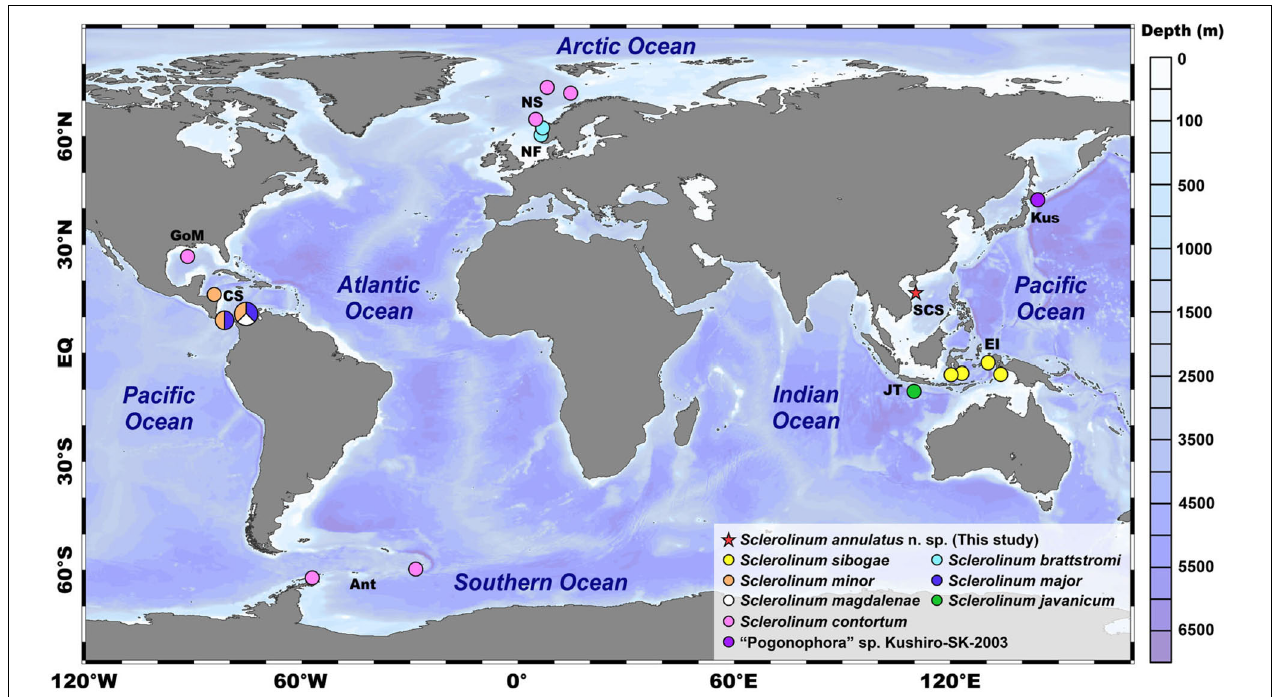
FIGURE 1 | A map showing the known distributions of seven described Sclerolinum species, the type locality of Sclerolinum annulatus n. sp. (i.e., the Haima cold seep in the SCS as indicated by a red asterisk), along with an undescribed species of Sclerolinum “Pogonophora” sp. Kushiro-SK-2003. The map was created using Ocean Data View (ODV) v.5.0 (https://odv.awi.de). Color coding represents the water depth (unit: m). Ant, Antarctic; CS, Caribbean Sea; EI, East Indies; EQ, equator; GoM, Golf of Mexico; JT, Java Trench; Kus, Kushiro; NF, Norwegian fiords; NS, Norwegian Sea; SCS, South China Sea. Notes: the geographic coordinates of